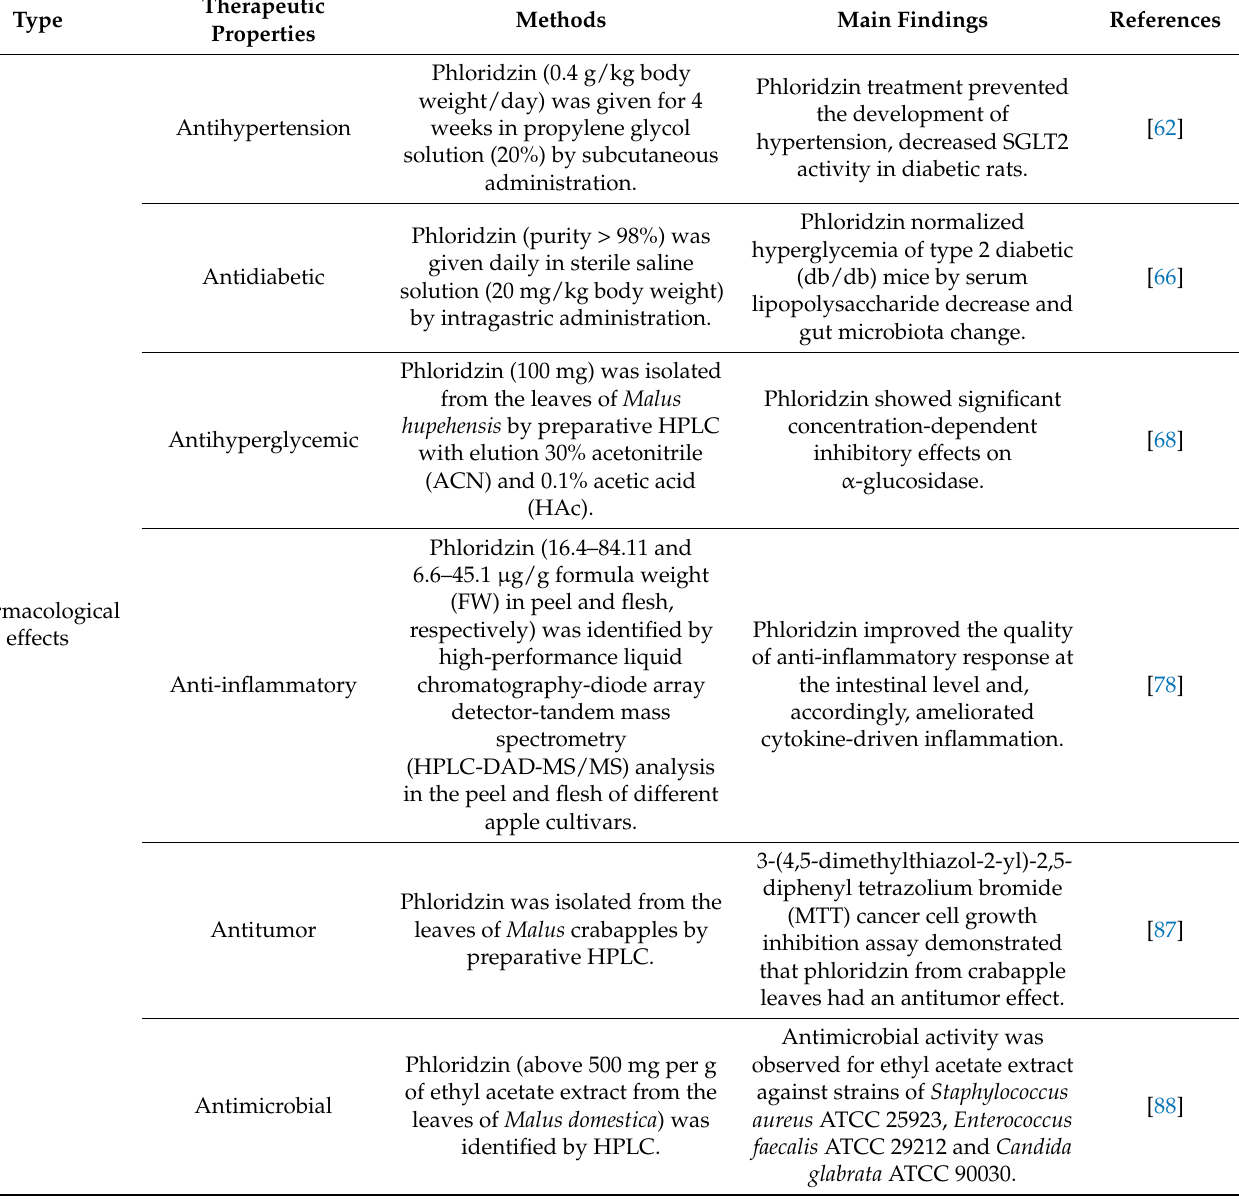
Table 4. Therapeutic properties of